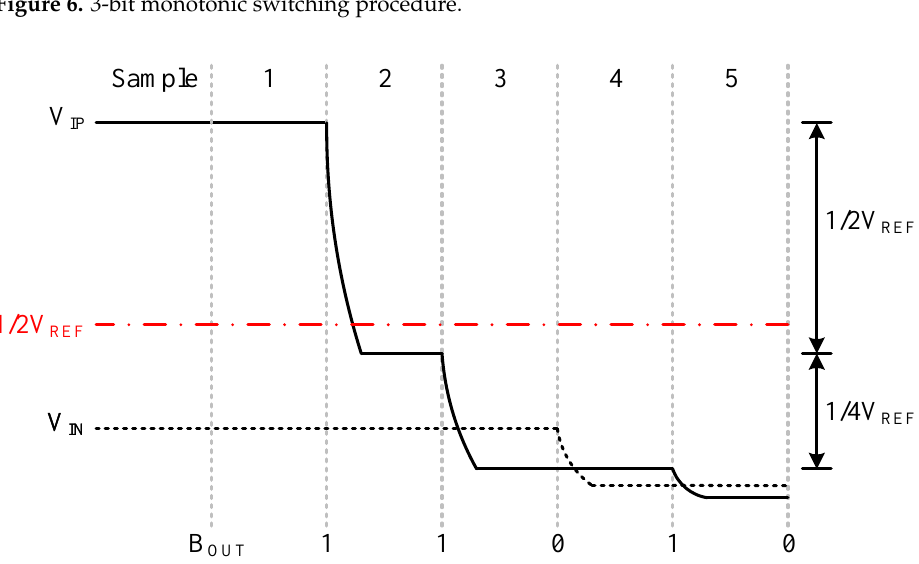
Figure 7. Waveform of monotonic switching procedure. The average switching energy for an n-bit SAR ADC using this switching procedure can be derived